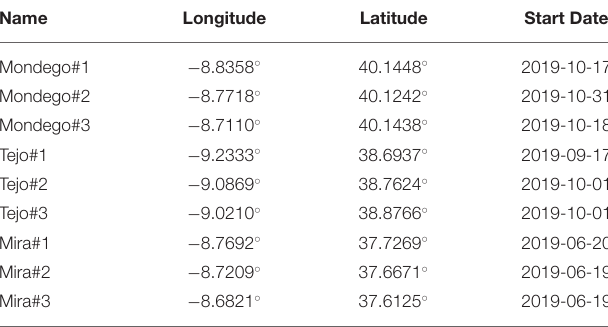
TABLE 1 | Coordinates of the nine locations and their respective starting